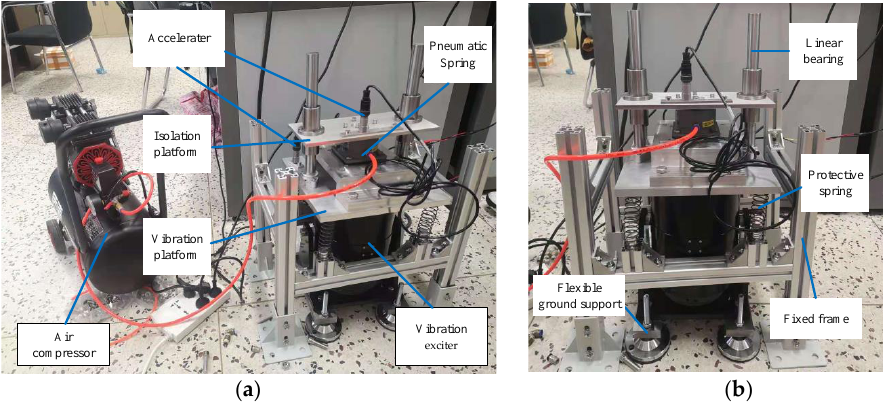
Figure 13. The test prototype of the vibration isolation system. ( a ) The vibration isolation system; ( b ) The vibration isolation platform.